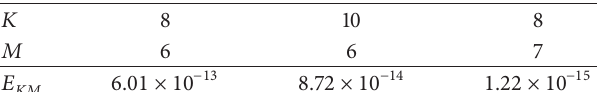
Table 4: The maximum errors of 𝐸 𝐾𝑀 for different values of 𝐾 and 𝑀